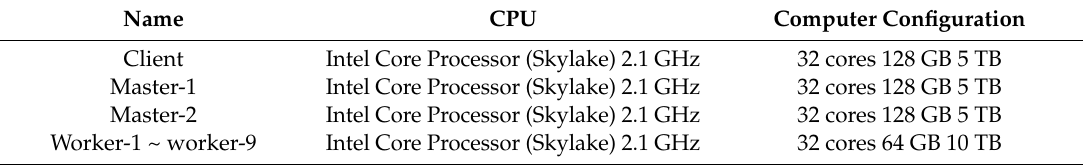
Table 1. Configuration and parameters of virtual machines of